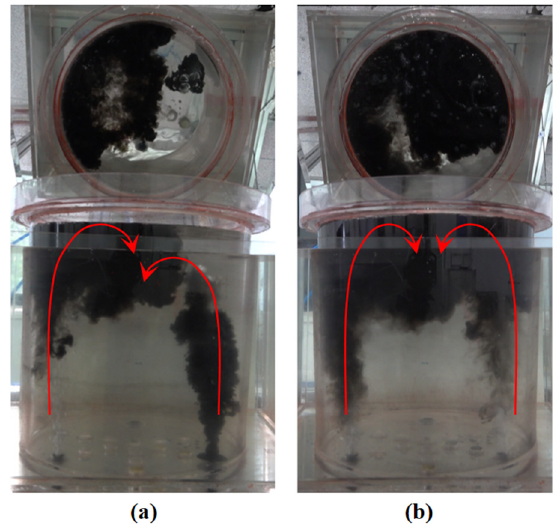
Figure 7. Comparison of flow stream at different argon-flow modes: ( a ) S–P mode, ( b ) P–P mode.